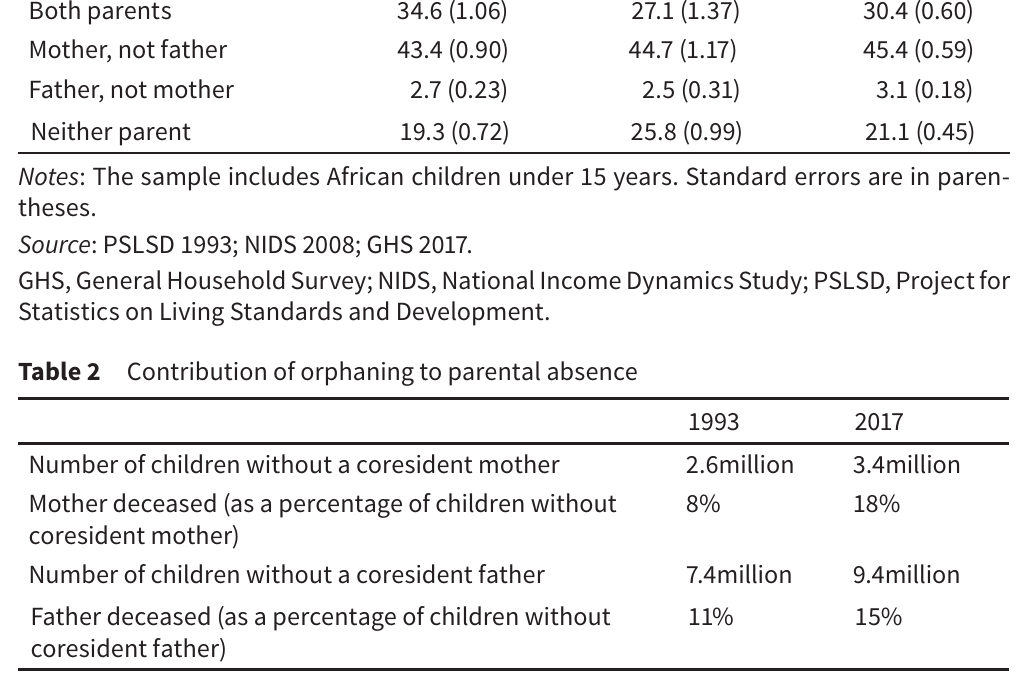
Parental co-residence with children, 1993–2017 Child lives with 1993 Both parents